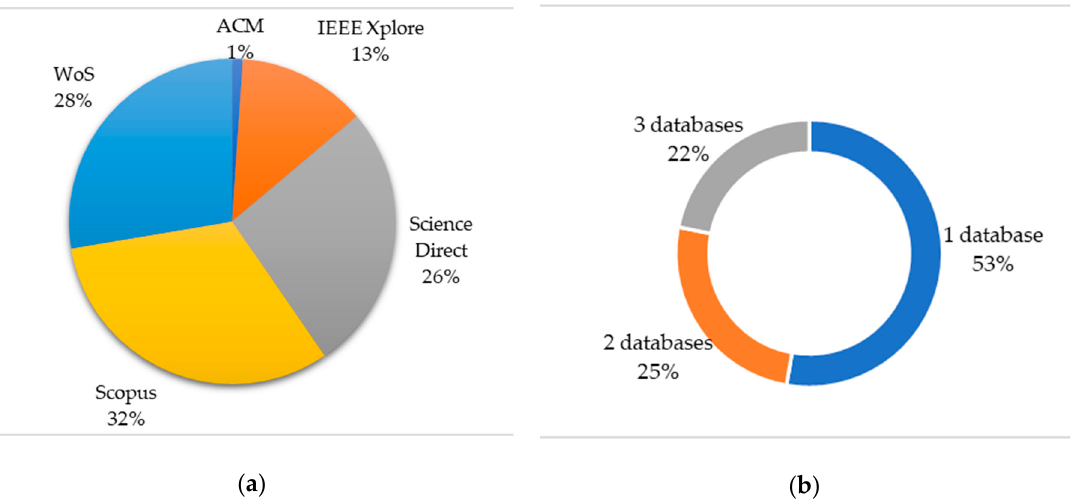
Figure 3. Distribution of the papers according to the research database ( a ) and the number of databases where they were found ( b ).